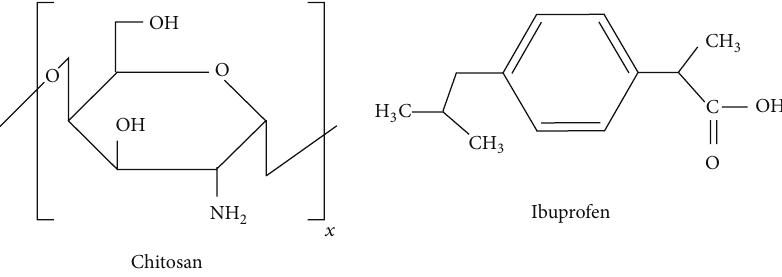
Figure 7: Structure of CS and